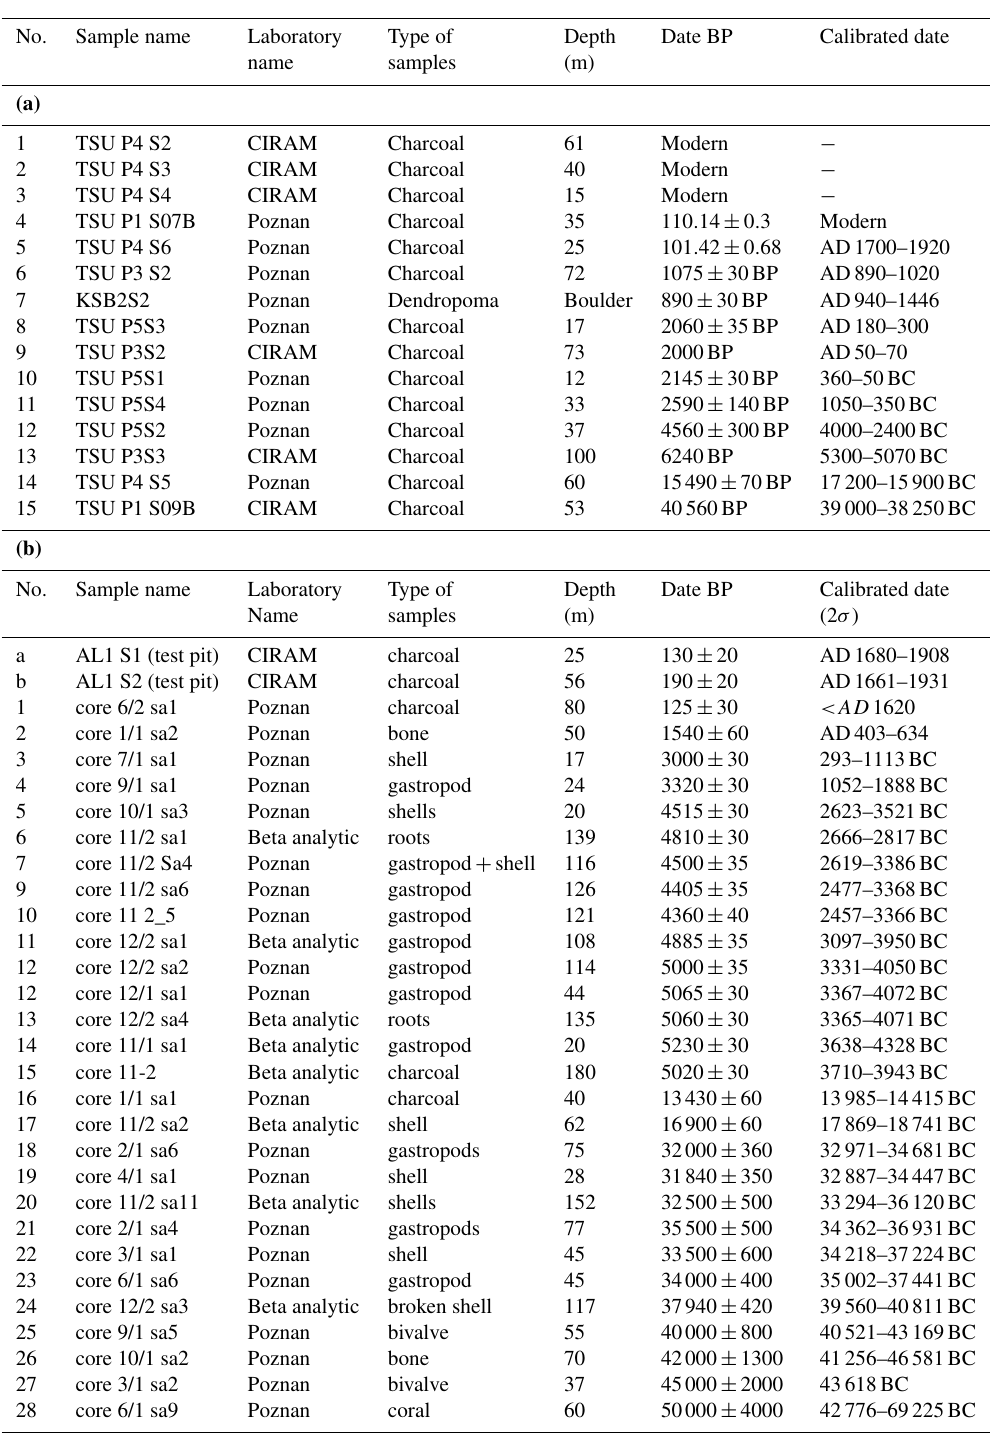
Table 2. (a) Radiocarbon dating samples and calibrated age at Kefr Saber site using OxCal v4.2.4 (Bronk-Ramsey, 2013). (b) Radiocarbon dating samples and calibrated date in El Alamein site using OxCal v4.2.4 (Bronk-Ramsey,